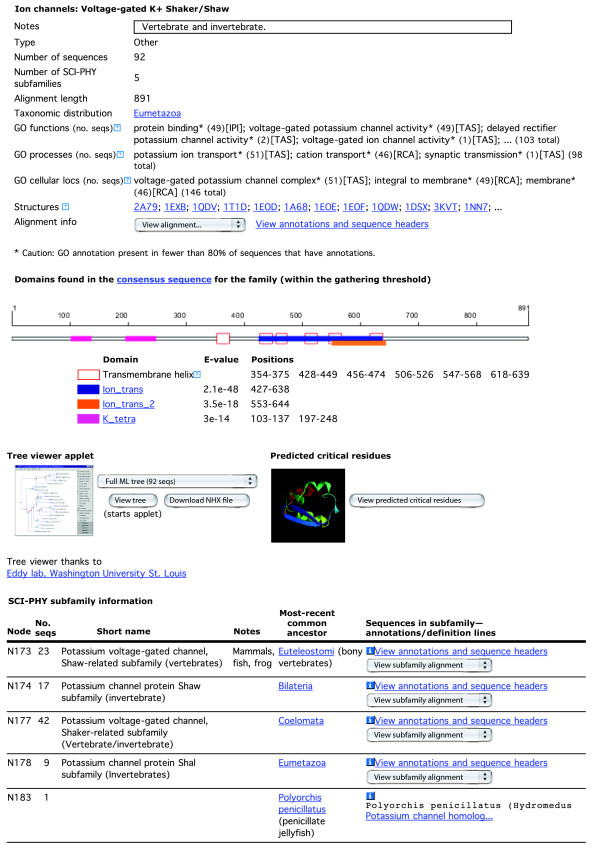
PhyloFacts book: Voltage-gated K+ channels, Shaker/Shaw subtypes. Each book contains summary data at the top of the book page, including book type, number of sequences, number of predicted subfamilies, and taxonomic distribution. PFAM domains matching the book consensus sequence are displayed along with predicted transmembrane domains and signal peptides. Phylogenetic trees and multiple sequence alignments can be viewed or downloaded, for the family as a whole or for individual subfamilies. Predicted critical residues have been identified and are plotted on homologous PDB structures, where available (Figure 5). Clicking on 'View annotations and sequence headers' displays GO annotations and evidence codes for sequences in the family as a whole and for individual subfamilies.